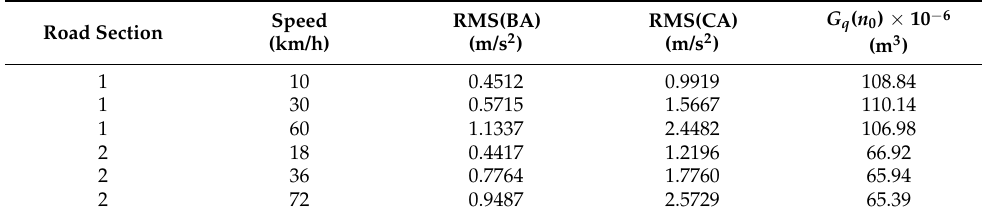
Table 5. Test results of different speeds in each road